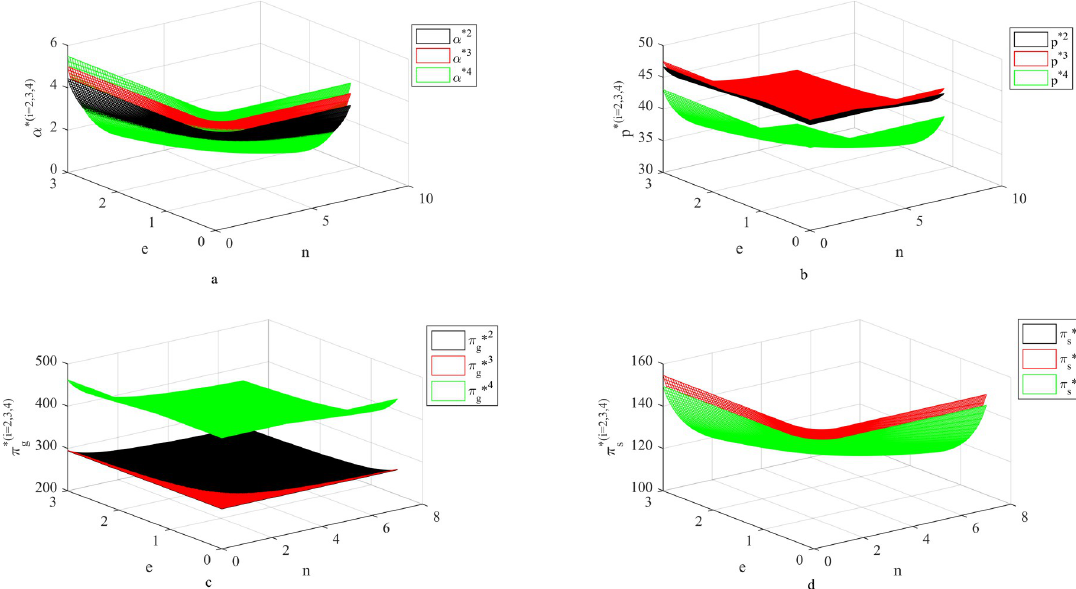
Fig 4. Influence of n , e on fresh-keeping decisions and